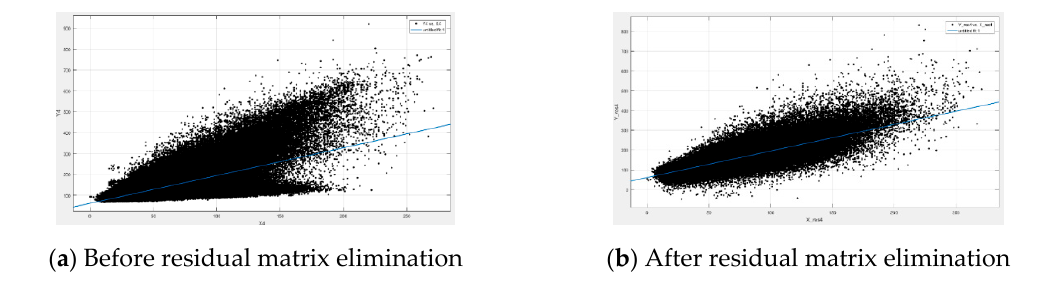
Figure 3. The DN distribution of the panchromatic image and multi-spectral band 1, where ( a ) is the distribution before residual matrix elimination, and ( b ) is the distribution after residual matrix elimination. Table 2. Fitting results before and after the residual matrix elimination. RMSE—root-mean-square error. k b R